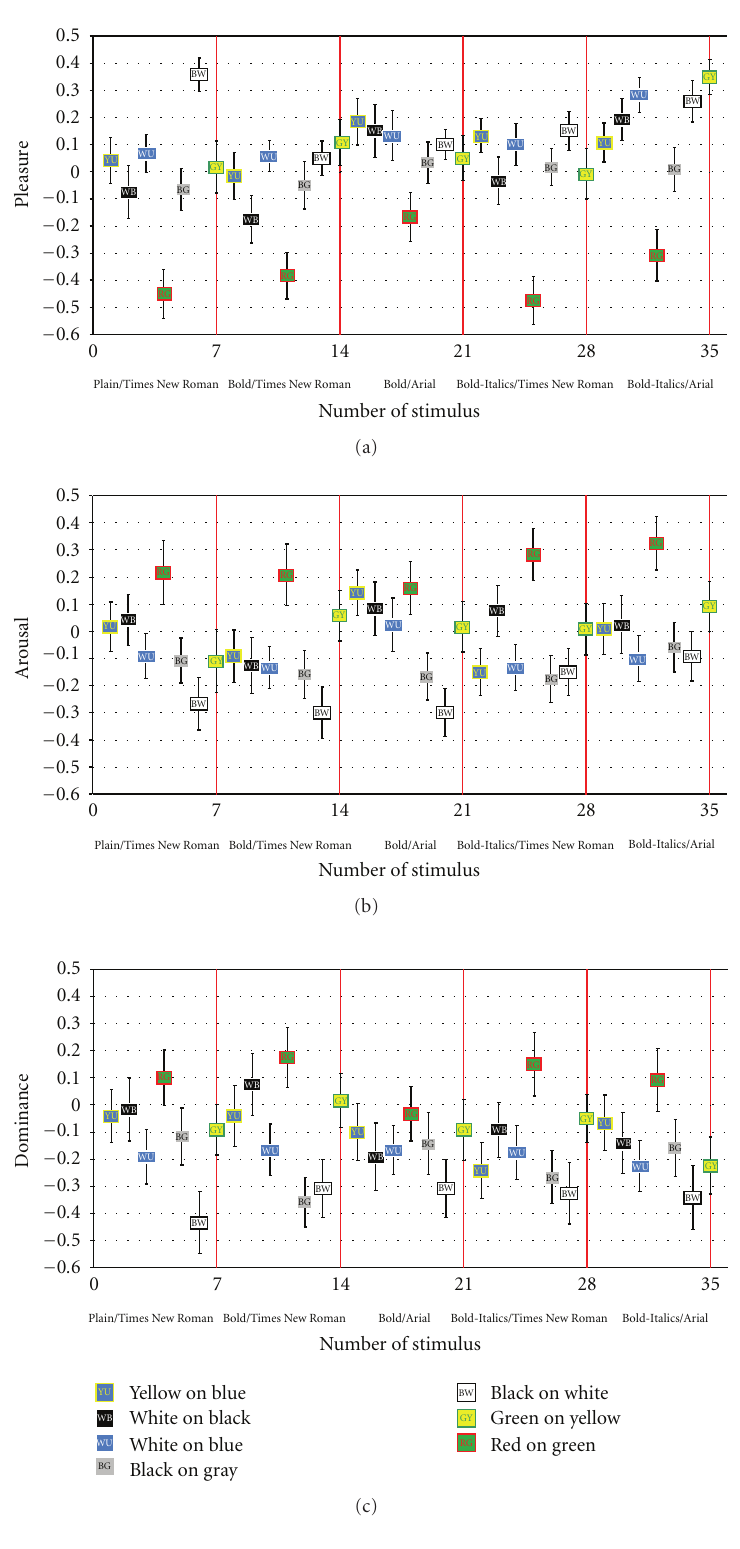
Figure 4: (a) Mean values and standard error of the results for all the text font/background color combination stimuli on the Pleasure axis. (b) Mean values and standard error of the results for all the text font/background color combination stimuli on the Arousal axis. (c) Mean values and standard error of the results for all the text font/background color combination stimuli on the Dominance